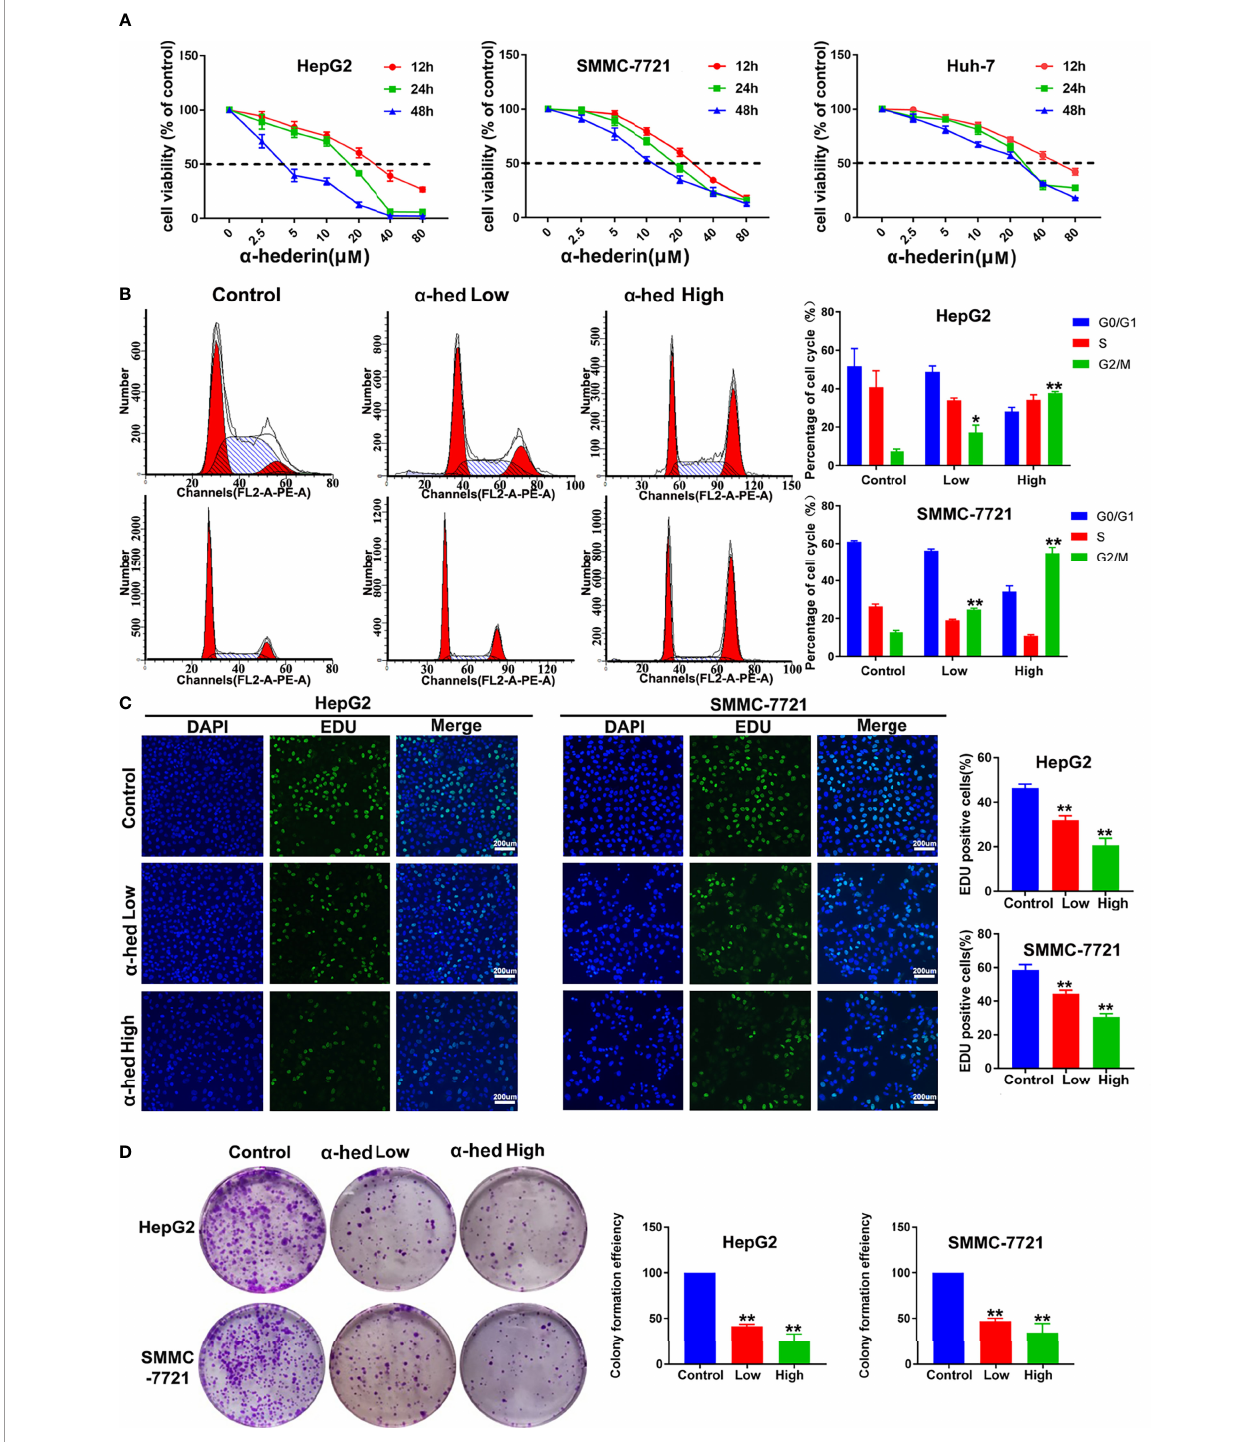
FIGURE 1 | a -hederin inhibited the proliferation of HCC cell lines. (A) HepG2, SMMC-7721 or Huh-7 cells were treated with the indicated concentrations of a -hederin for 12, 24 or 48 hours, followed by MTT cell viability assay. (B) Cell cycle analysis of HepG2 and SMMC-7721 cells treated with a -hederin at low (10 µM) or high (20 µM) concentration for 24 hours. (C) Representative images and analysis of EdU staining in HepG2 and SMMC-7721 cells treated with a -hederin at low (10 µM) or high (20 µM) concentration for 24 hours. (D) Representative images and quantitative analysis of colony numbers of HepG2 and SMMC-7721 cells treated with a -hederin at low (10 µM) or high (20 µM) concentration for 24 hours. Signi fi cance: * p < 0.05 versus control, ** p < 0.01 versus